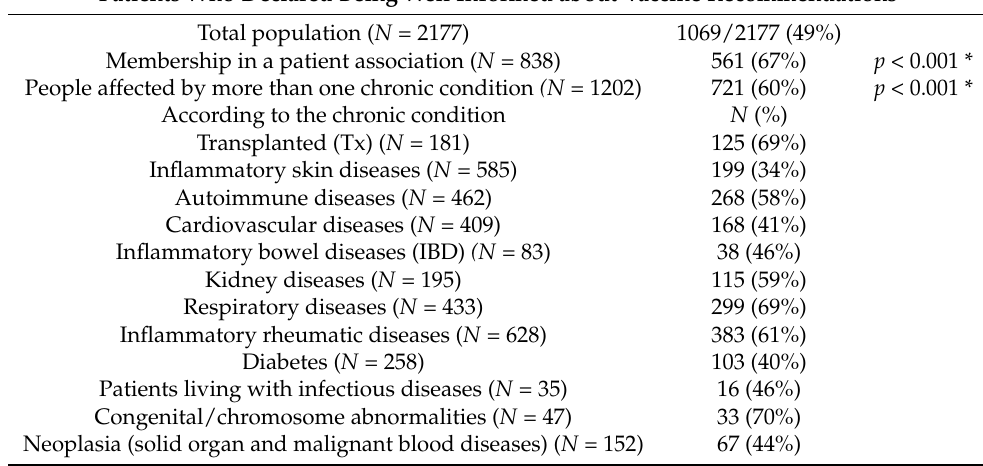
Table 2. Vaccine recommendation